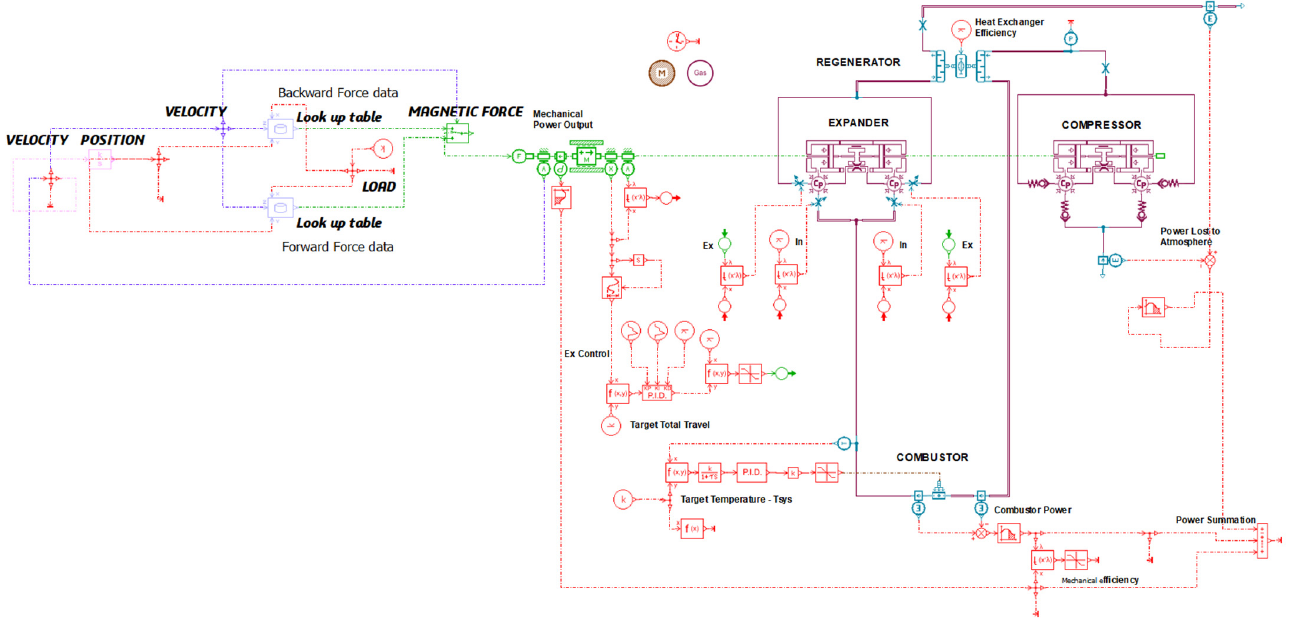
Figure 7. Linear generator and engine system model in AMESim software (Simcenter Amesim 2020.1 by Siemens AG,